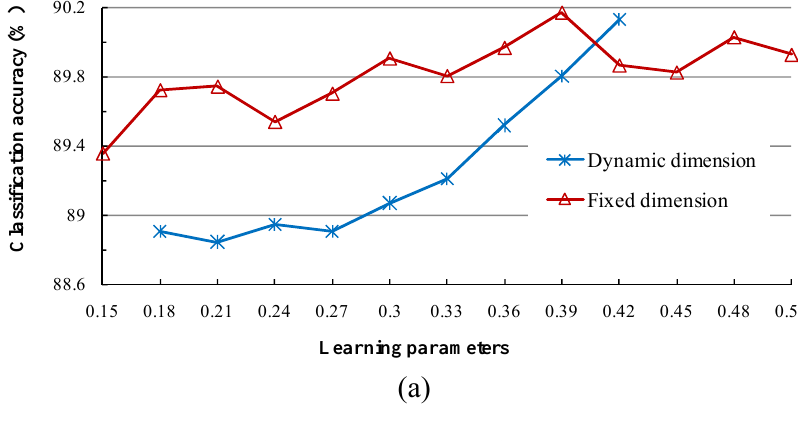
Maximum iteration vs. Learning parameter